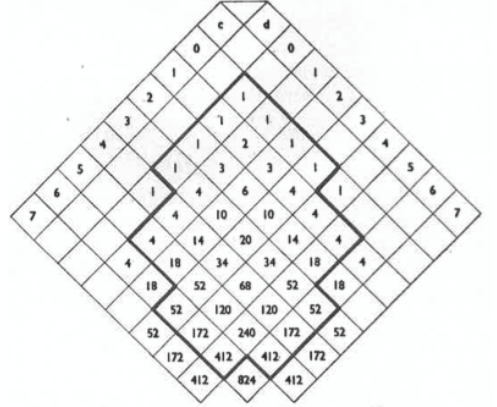
Figure 1. The arithmetical triangle